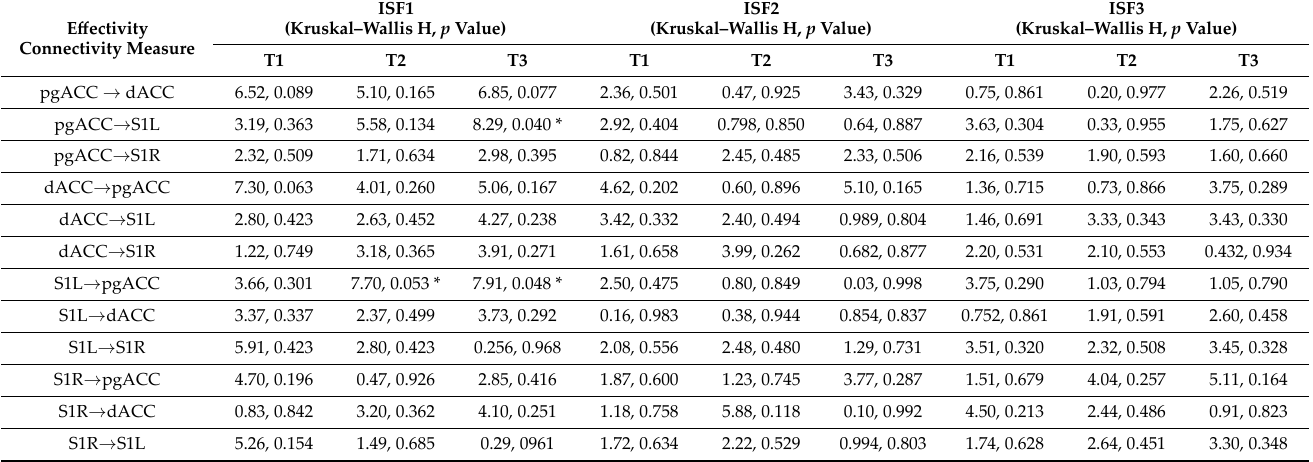
Table 2. Between‑group comparisons for the effective connectivity